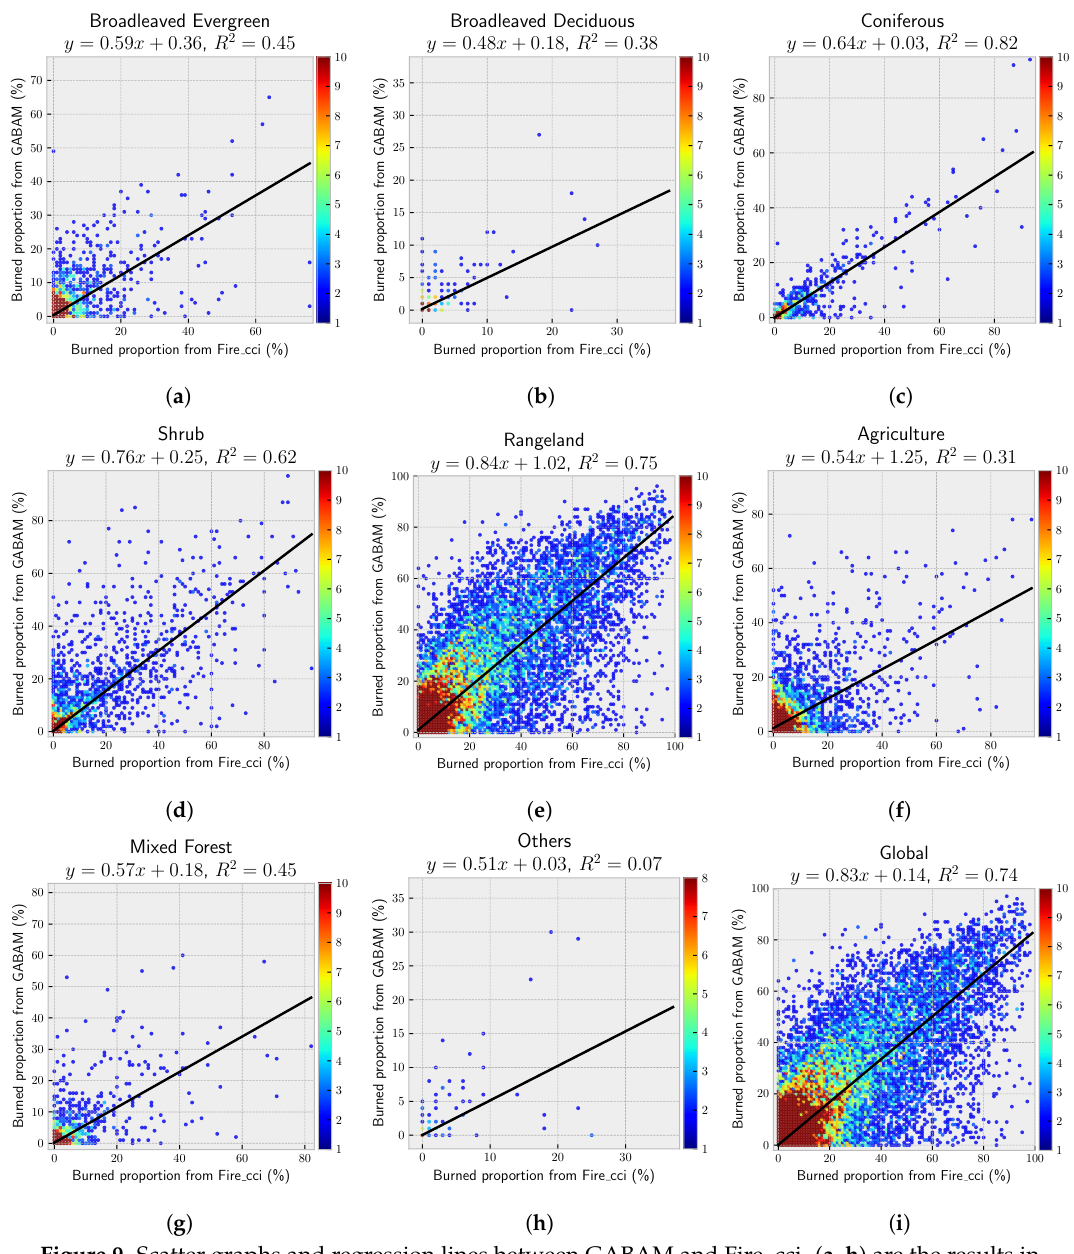
Figure 9. Scatter graphs and regression lines between GABAM and Fire_cci. ( a – h ) are the results in different land cover categories; ( i ) shows the global result in all kinds of land covers. The color scheme illustrates the number of grid cells having the same proportion